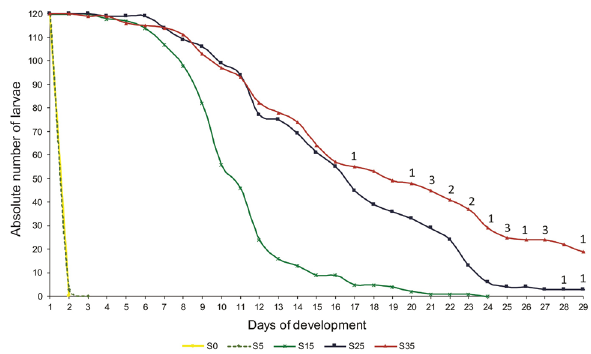
Figure 2. Leptuca leptodactyla . Survival curves (in absolute number) of the larvae during the five salinity treatments. S0: 0 PSU; S5: 5 PSU; S15: 15 PSU; S25: 25 PSU and S35: 35 PSU. The numbers above the survival curves of S25 and S35 indicate the number of zoea that underwent ecdysis to megalopa